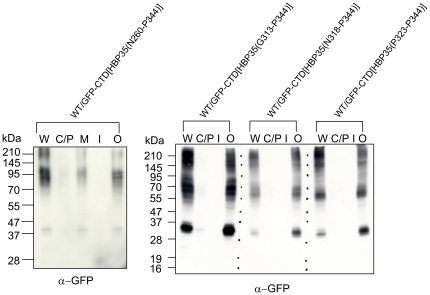
Cell fractionation analysis of P. gingivalis expressing GFP-CTD[HBP35] fusion proteins.
P. gingivalis wild-type cells expressing GFP-CTD[HBP35(N260-P344)], GFP-CTD[HBP35(G313-P344)] or GFP-CTD[HBP35(P323-P344)] were fractionated into whole cell lysate (W), a cytoplasm/periplasmic fraction (C/P), a total membrane fraction (M), an inner membrane fraction (I) and an outer membrane fraction (O).